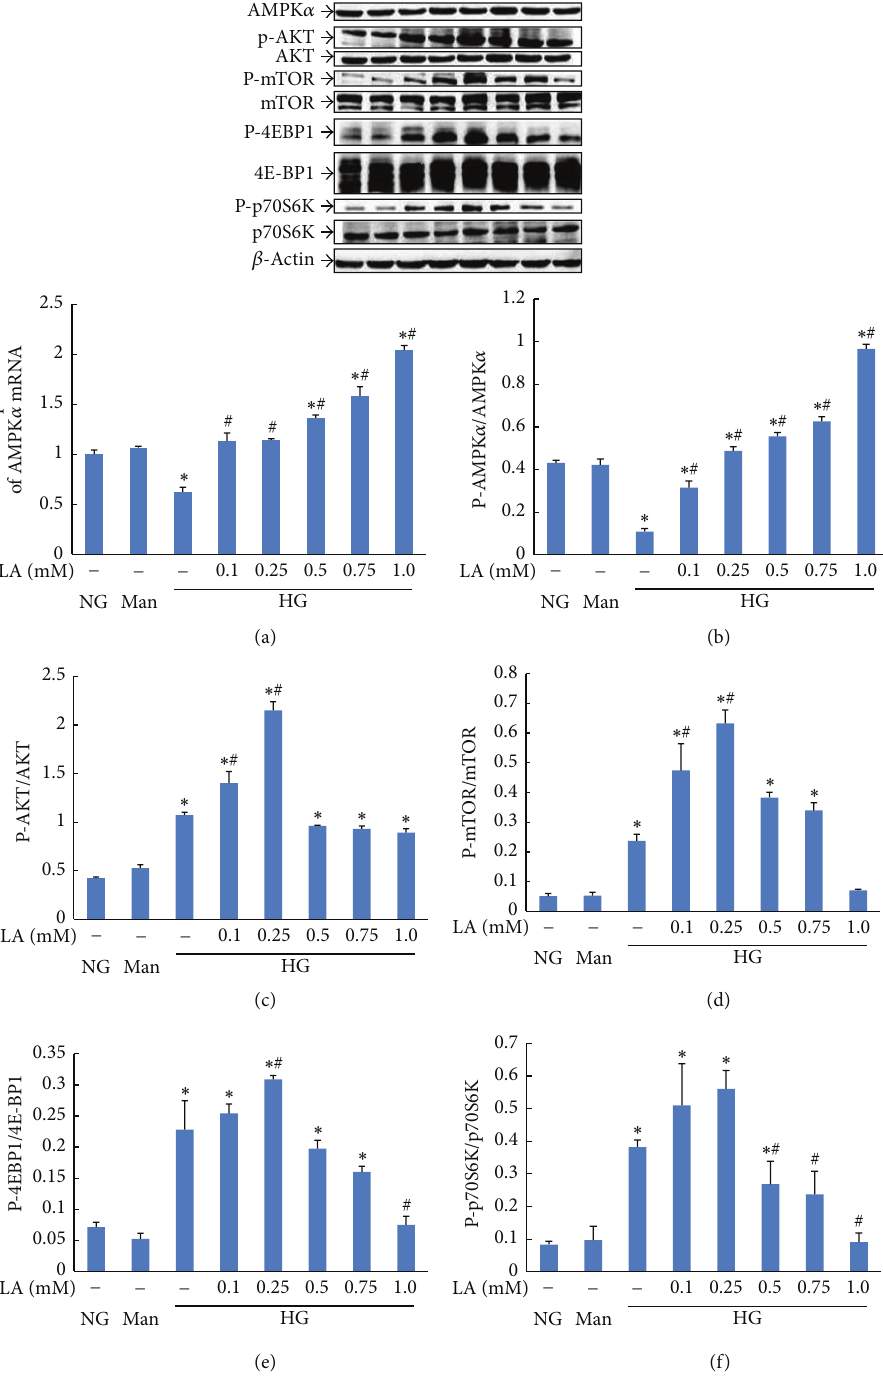
Figure4:Concentration-dependentLAregulatedexpressionsofAMPK,AKT,mTOR,4E-BP1,andp70S6Kinhighglucose-treatedmesangial cells. MCs were preincubated for 1h with high glucose (30mmol/L) and then stimulated with various concentrations (0.1–1.0mmol/L) of